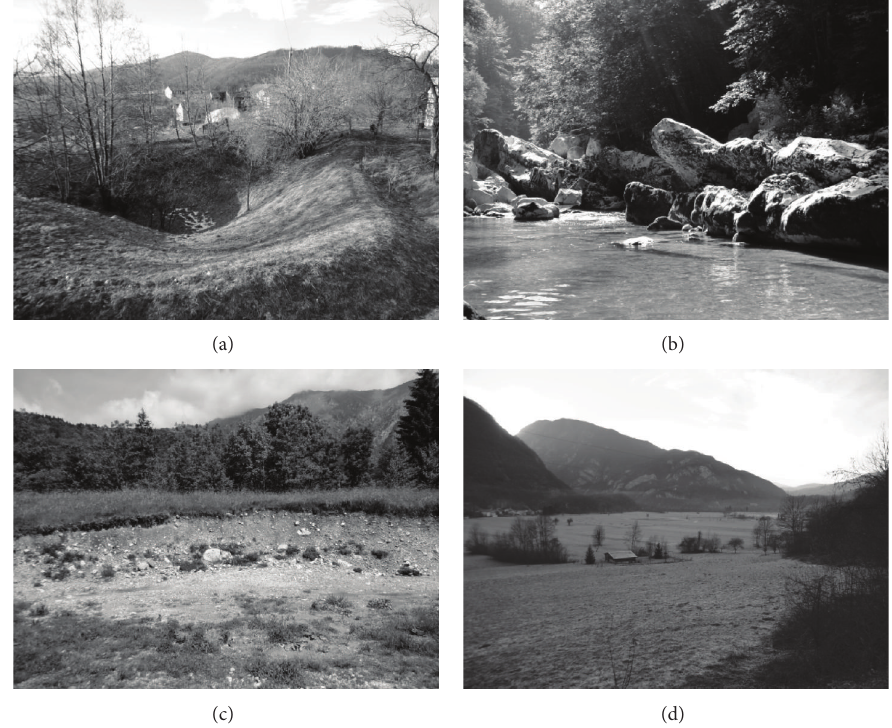
Figure 3: (a) Karst sinkhole in coral limestone represents a depositional place for significant amount of weathered material; Robidiˇsˇce in the background. (b) Limestone breccia in Nadiˇza valley south of Logje is typically bedded. (c) Diamicton near Breginj, in the background Mt. Stol built of Dachstein limestone. (d) Alluvial fan sediments form gentle slopes above Kred polje, which is composed of fine grained alluvial sediments which promote to alluvial sediments near Nadiˇza River